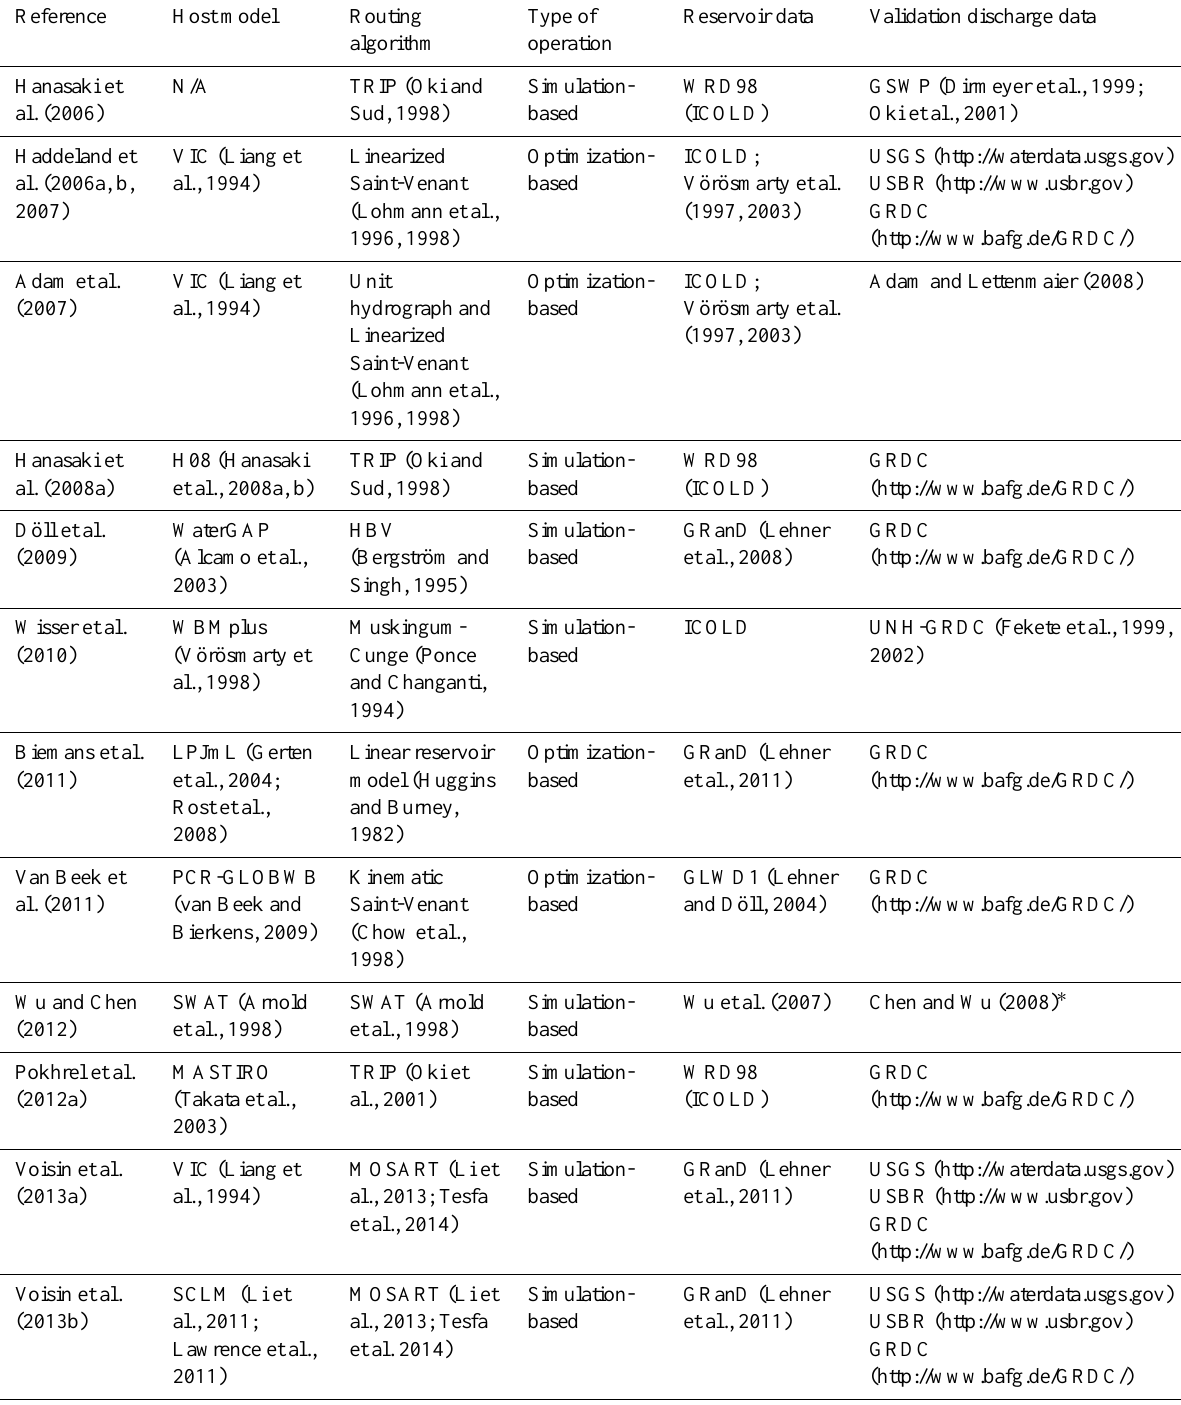
Table 2. Representative examples of available macro-scale reservoir operation algorithms implemented in large-scale